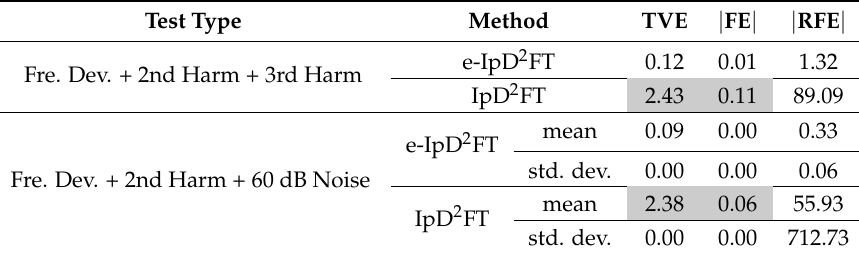
Table 6. TVEs (%), | FE | s (Hz) and | RFE | s (Hz/s) returned by the e-IpD 2 FT and IpD 2 FT. The Hanning window is adopted in the e-IpD 2 FT and IpD 2 FT. The observation window is three cycles long. The TVE, FE and RFE limits in the standard are the same as in Table 4. The meaning of the gray cells is the same as in Table